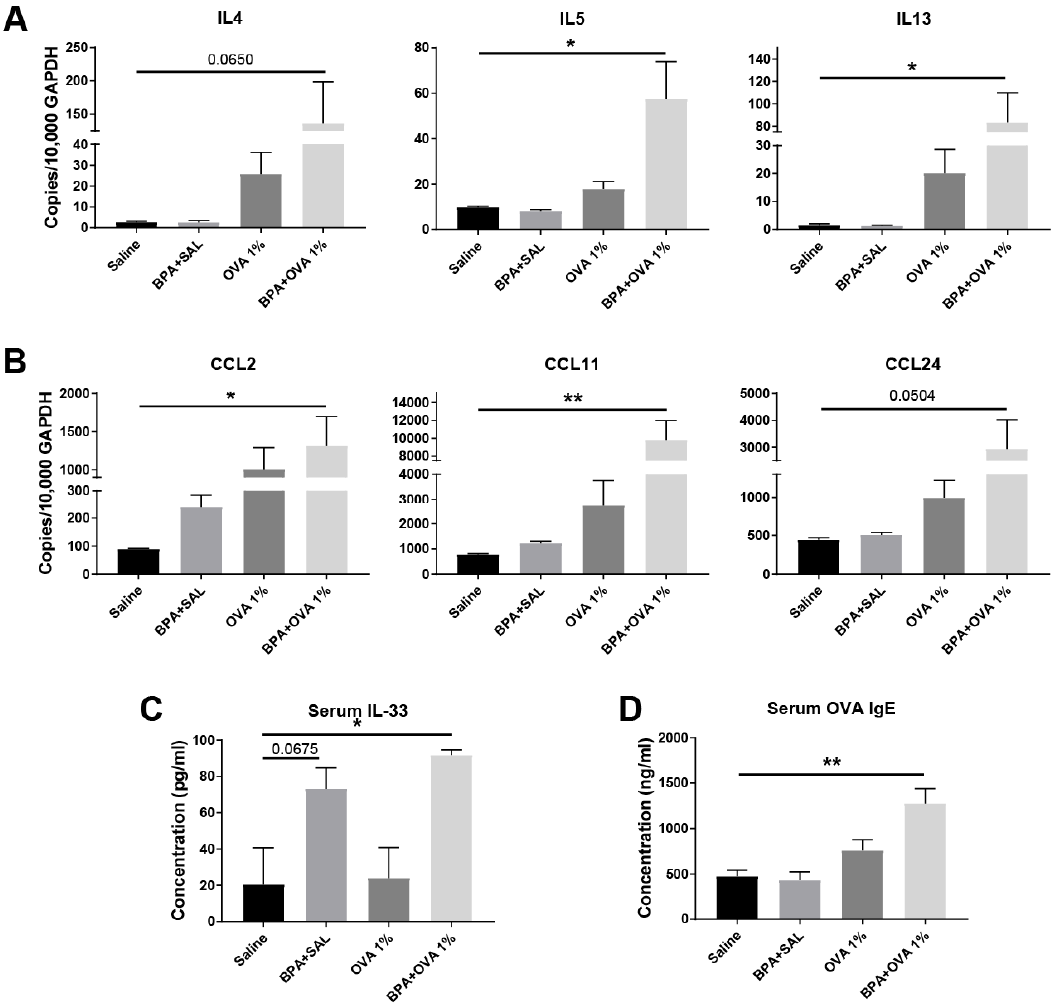
Figure 4. Chronic systemic BPA exposure induces allergic sensitization to innocuous OVA antigen exposure followed by the expression of Type 2 immune mediators. ( A ) Lung tissue expression of Type 2 cytokines by qPCR. ( B ) Lung tissue expression of chemokines by qPCR. ( C ) Serum protein levels of alarmin cytokine IL-33 by ELISA. ( D ) Serum levels of OVA-specific IgE antibodies by ELISA. N = 2 in saline group, N = 3-4 mice in treatment groups; all data shown from an experiment performed one time. *, p < 0.05, **, p < 0.01 by ANOVA.